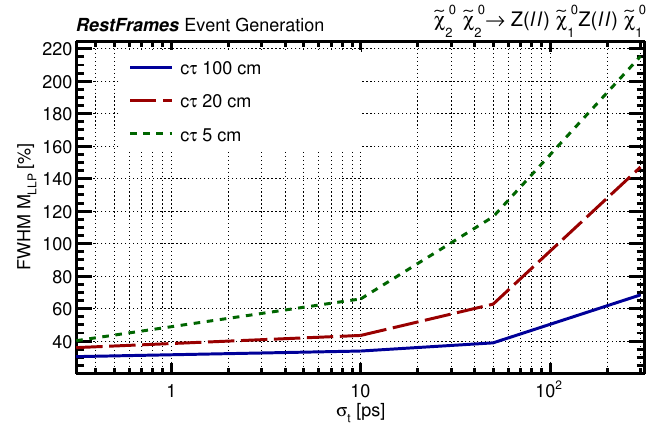
Figure 6 . Distributions of reconstructed masses in simulated events. (Left) Reconstructed M LLP mass for di(cid:11)erent neutralino lifetimes. (Right) Reconstructed LSP mass for di(cid:11)erent true masses. An LLP mass of 400 GeV and lifetime of 20 cm is assumed when simulating these events unless otherwise noted.